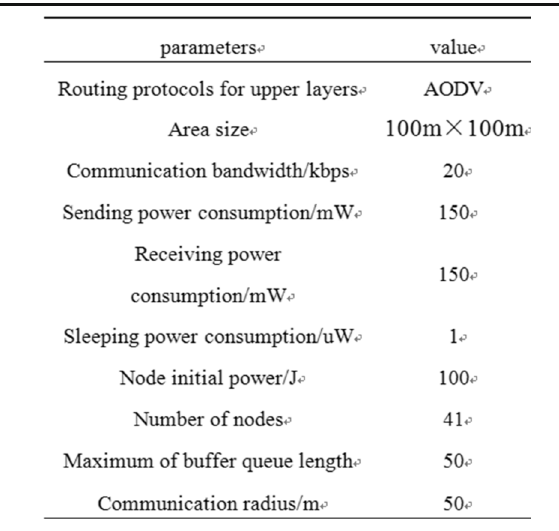
Table 2 Simulation parameters of experiment